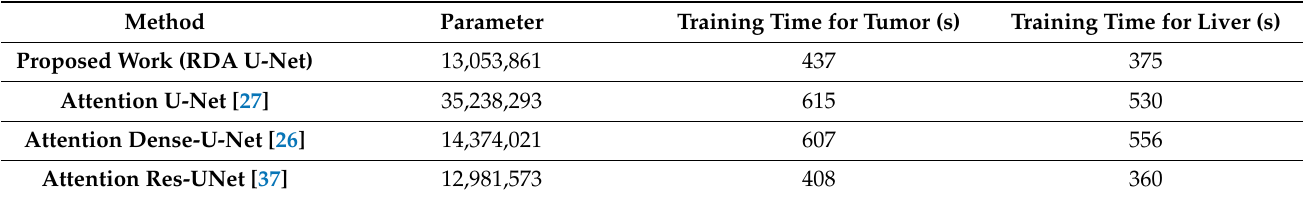
Table 1. Comparison of model parameters and training time.